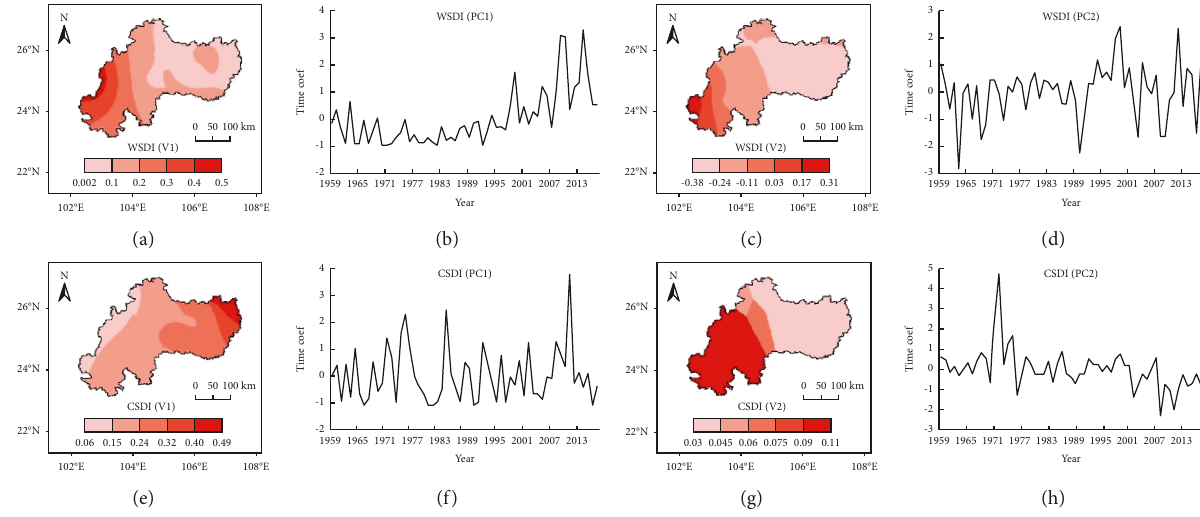
Figure 6: The first and second eigenvectors and their time coefficients of extreme temperature duration positive, with small differences in trends. The component values of FD (V1) are distributed along the south-north, with the center of high values located in the north of the basin and decreasing to the south. The center of high values of TX10p (V1) is located in the middle part of the watershed, with the component values decreasing along the surrounding area.